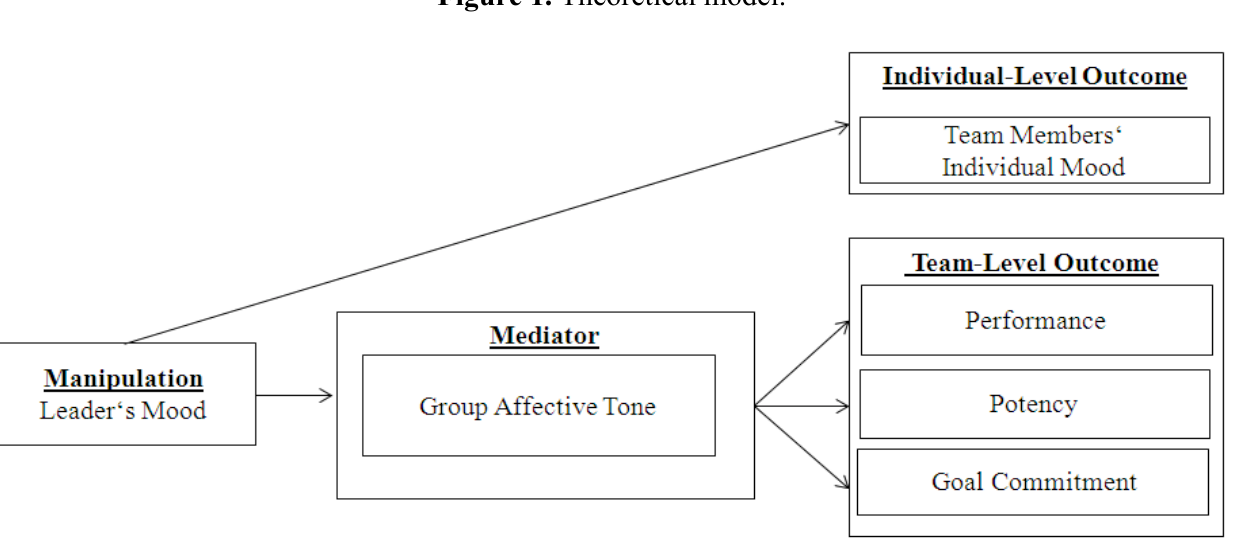
Figure 1. Theoretical